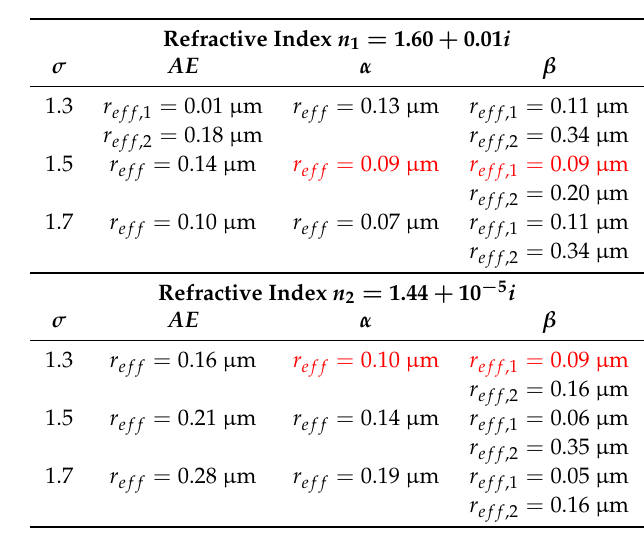
Table 1. Different possibilities for an effective radius, r ef f , depending on the standard deviation σ of the distribution and refractive indexes n 1 and n 2 for given parameters α = 1, β = − 1.5, and AE = 1. The best matching combination of α and β is highlighted in